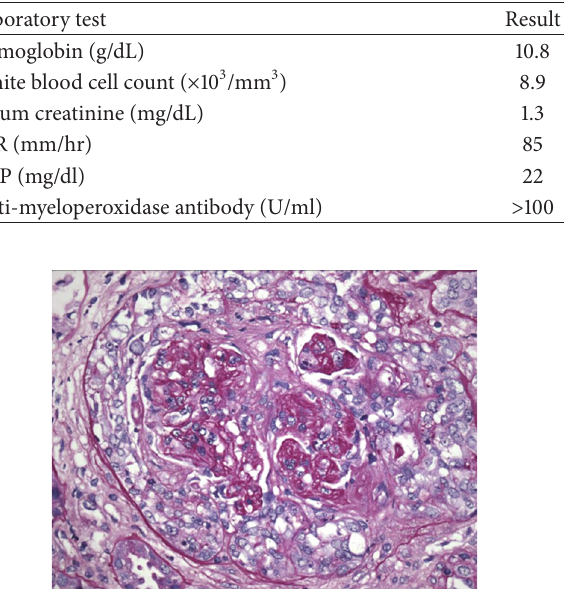
Figure 1: Glomerulus showing cellular crescent formation (H and E stain ×